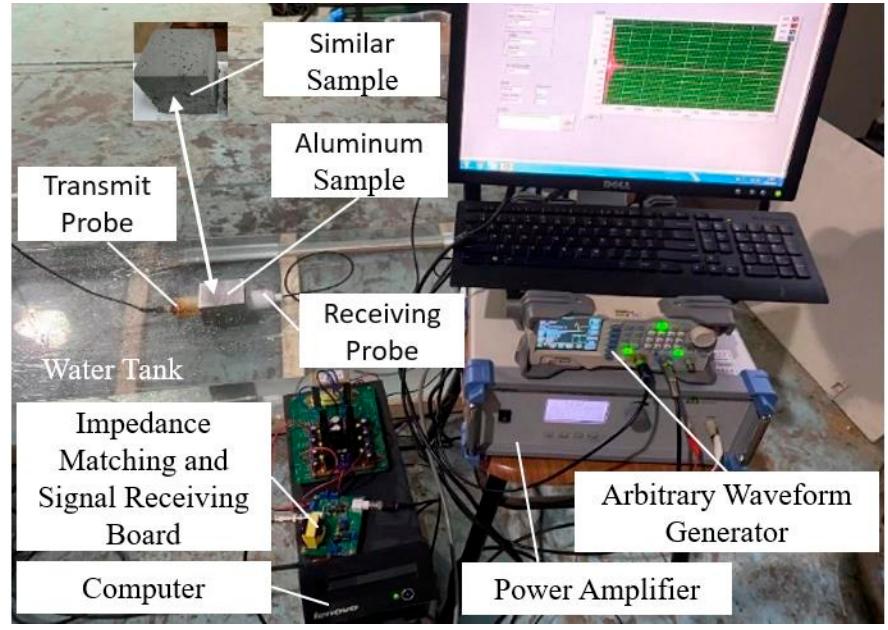
Figure 2. Ultrasonic transmission experimental equipment.